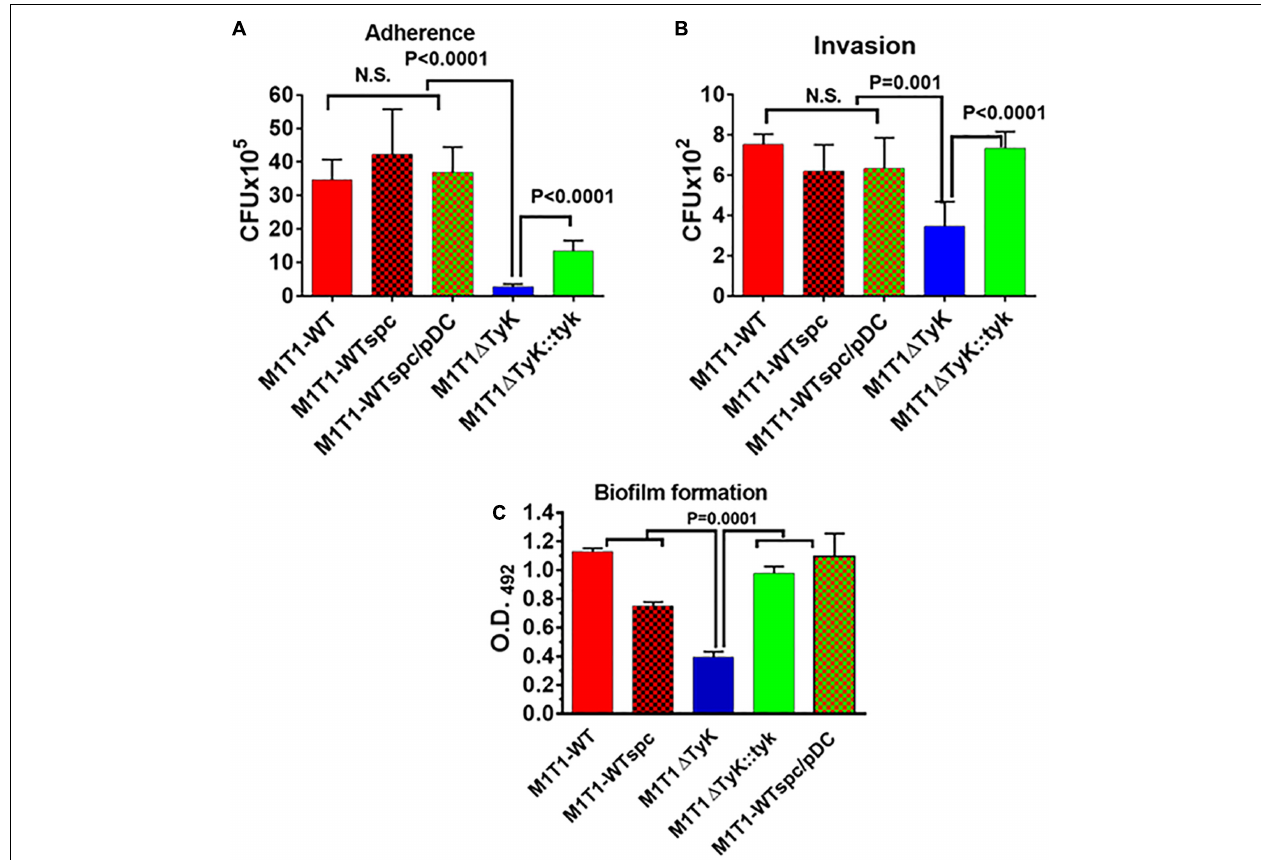
FIGURE 8 | Impact of the absence of SP-TyK on the GAS ability to adhere to and invade the host cells and to form in vitro biofilms. (A) Adherence to and (B) Invasion of human lung epithelial cell lines (A549) by M1T1 wild-type control, M1T1 (cid:49) TyK mutant and M1T1 (cid:49) TyK:: tyk complemented GAS strains [multiplicity of infection (MOI)-100:1::bacteria:cell] was observed after 3 h of co-culture in CO 2 incubator at 37 ◦ C using six-well tissue culture plates. Invasion assays were carried out in separate duplicate 12-well plates, after adherence assays and penicillin/gentamicin treatment for 90 min as described in the “Materials and Methods” section. The adherent bacteria and antibiotic treatment-protected internalized bacteria in these two assays were enumerated from the respective whole cell lysates employing the plate dilution method as CFU isolated on blood agar plates. Individual bars in the graphs represent average CFUs/ml ± S.D. A value pf p < 0.05 was treated as a significant difference. (C) Polystyrene 12-well tissue culture plate-based assays of M1T1-wild-type control, M1T1 (cid:49) TyK mutant, M1T1 (cid:49) TyK:: tyk complemented GAS strains to determine biofilm formation. Equal numbers of bacteria ( ∼ 5 × 10 6 CFU/ml/well) were seeded in 2 ml THY broth using 12-well polystyrene tissue culture plates, incubated for 72 h, and further processed as described in the description in the “Materials and Methods” section. The washed biofilms were dried and stained with Coomassie stain and extracted using 33% (V/V) acetic acid. The abundance of individual biofilms was measured spectrophotometrically in the form of Optical density at 490 nm. Individual bars in the graphs represent the average O.D. ± S.D. obtained from four independent experiments, each with three technical replicates. Values of p < 0.05 were treated as significant difference and determined by unpaired Student’s t -test with Welch correction using GraphPad Prism 6 software.